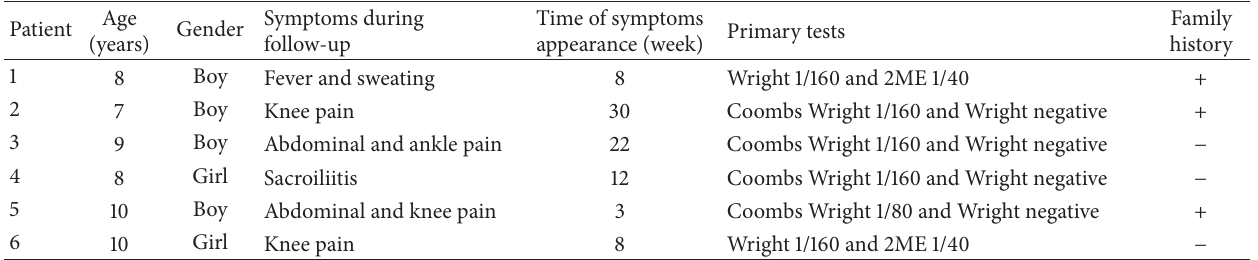
Table 2: Epidemiological and clinical data of the 6 symptomatic